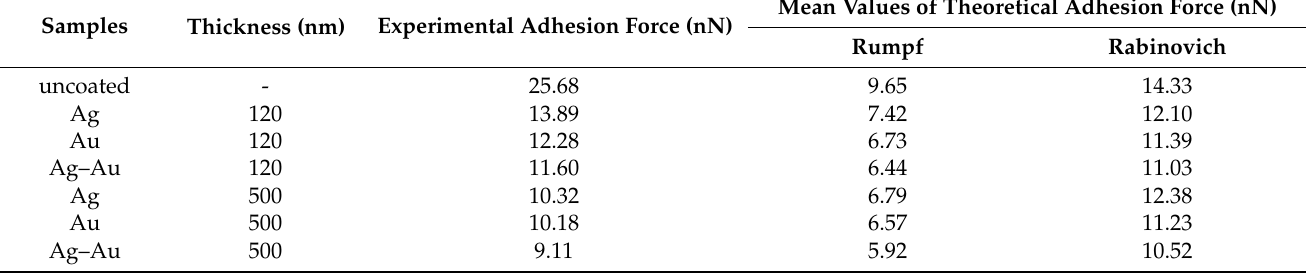
Table 4. The average force values of single and compound thin films were obtained by theoretical and experimental approaches for 120 and 500 nm thicknesses.